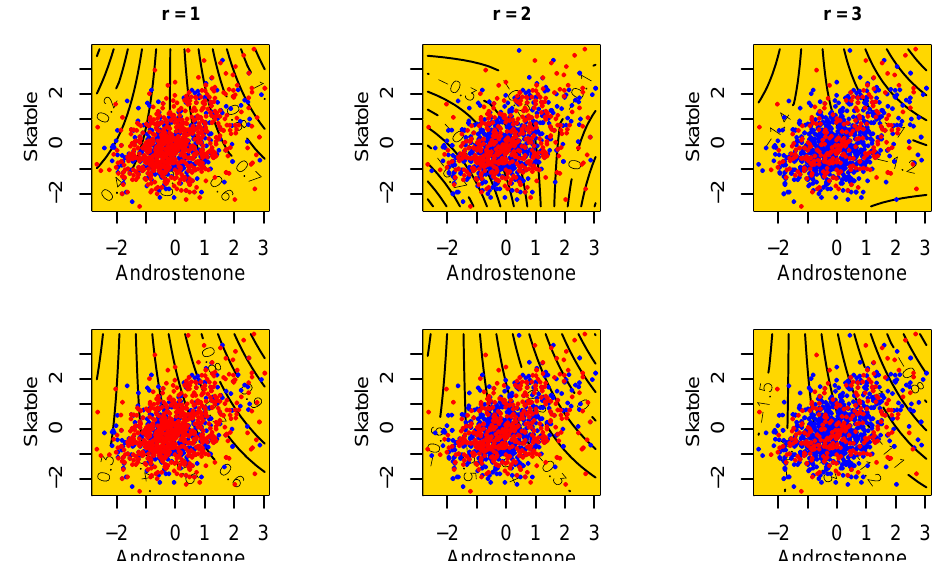
Figure 3. Fitted log-odds of sensory perception of boar taint under NPOM ( upper row) and POM ( lower row), having (log-transformed, standardized) androstenone and skatole, plus interaction as explanatory variables. Each column denotes the log-odds of panelist H’s rating falling into the upper categories with cut-point r = 1,2,3 (column 1 to 3). The data observed are drawn as colored dots: red, if Y i > r ; blue, if Y i ≤ r